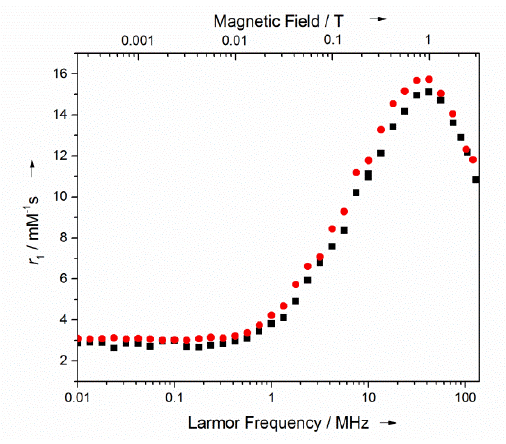
Figure 2. The nuclear magnetic relaxation dispersion (NMRD) profiles of Gd-DTPA ( ), MnTPPS ( ), m -MnP2 ( ), and MnP2( ) in 25 mM pH 7.2 HEPES buffer from 0.23 mT to 3 T at 25 °C. MnP r 1 Figure 6. NMRD profiles of MnP2-HSA ( Figure 6. NMRD profiles of MnP2-HSA ( ) and m -MnP2-HSA ( ) in pH 7.2 25 mM HEPES at 25 °C, measured from 0.01–128 MHz.